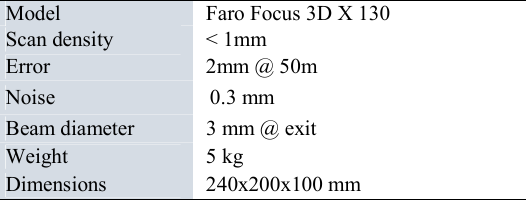
Table 2. 3D laser scanner technical specifications.